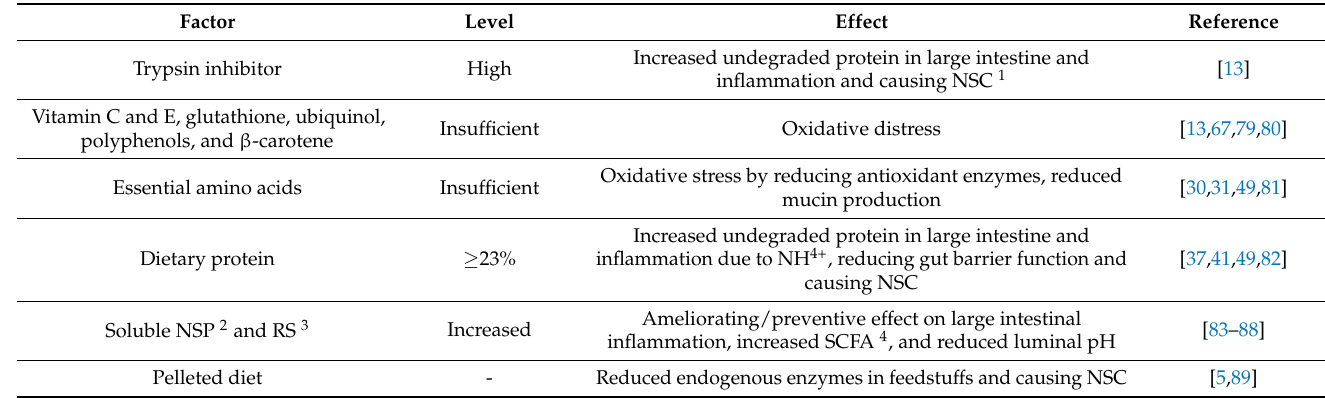
Table 3. Dietary factors involved in